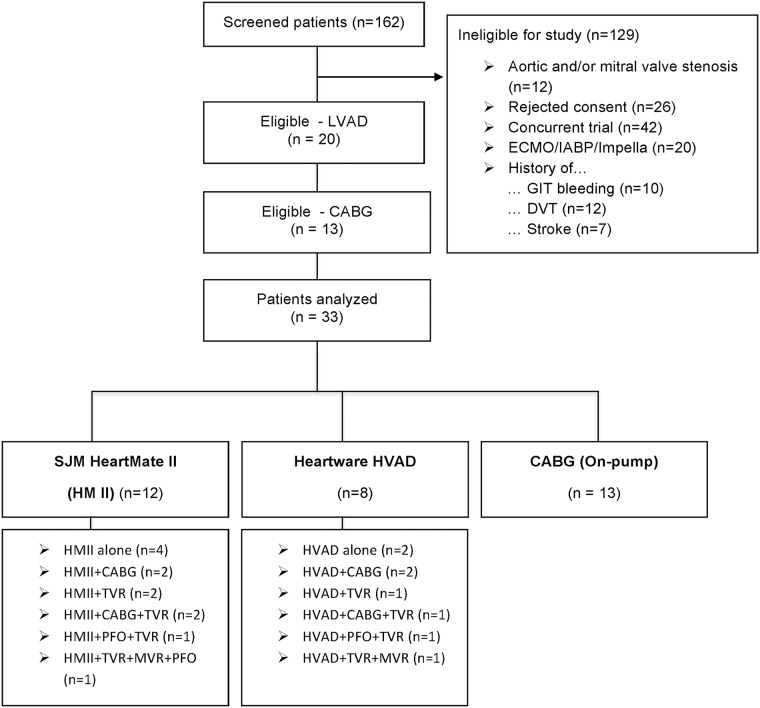
Study design and groups characteristics.CABG: coronary artery bypass graft; DVT: deep vein thrombosis; ECMO: extracorporeal membrane oxygenation; GI bleeding: gastrointestinal tract bleeding; HMII: HeartMate II; MVR: mitral valve reconstruction; IABP: intra-artery balloon pump; LVAD: left ventricular assist device PFO: patent foramen ovale; TVR: tricuspid valve reconstruction.